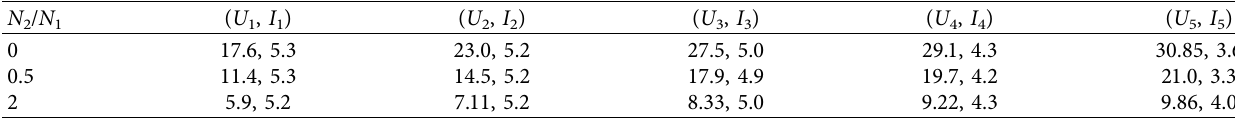
Figure 6: External buck circuit and load equivalent circuit diagram. Table 2: Data of current and voltage of PV